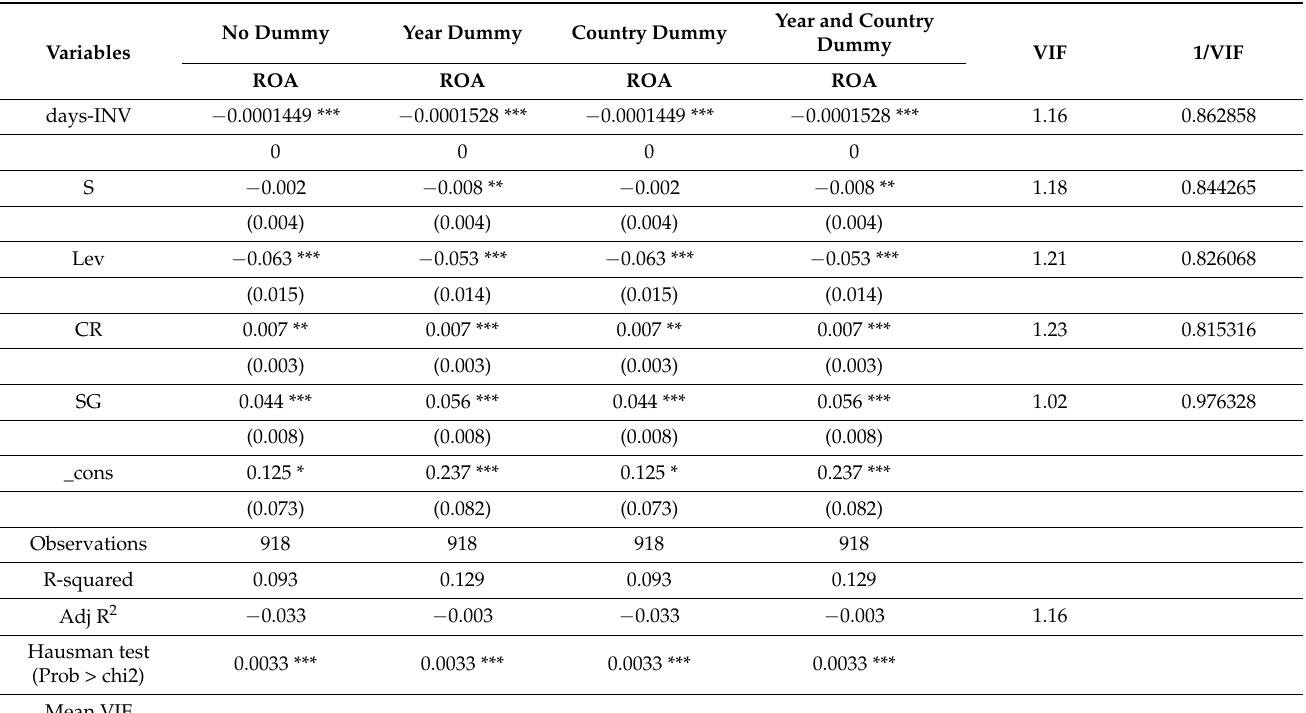
Table 8. Results of the fixed effects of days-INV on ROA, as per panel data regression (pre-pandemic period,